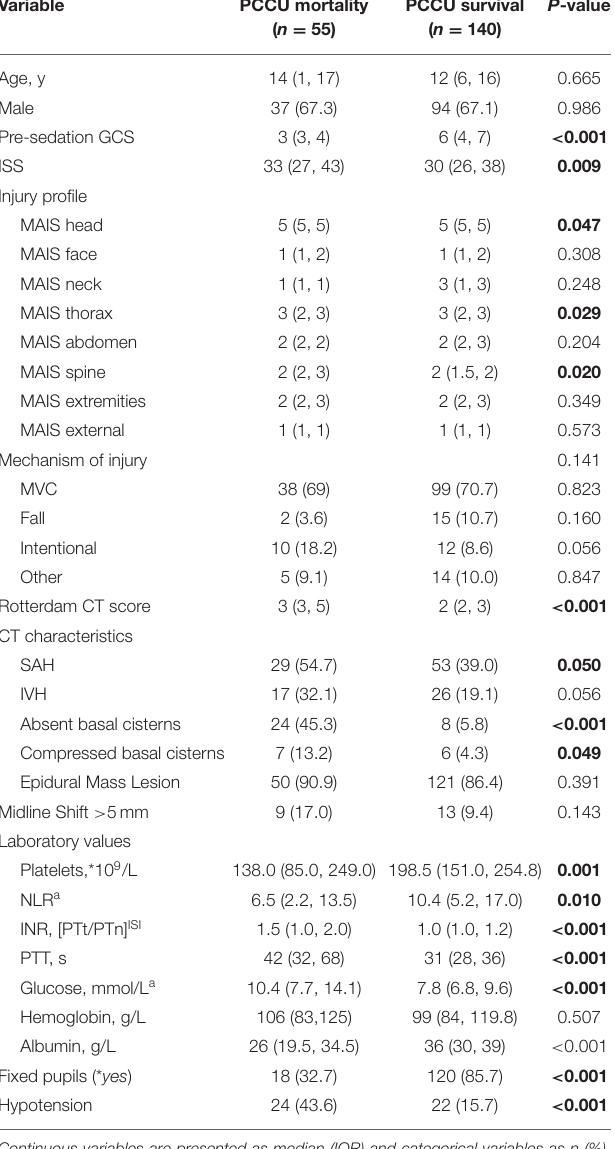
TABLE 1 | Bivariate analyses of admission variables, including demographic characteristics, laboratory data and CT findings of patients who died and survived in the PCCU.